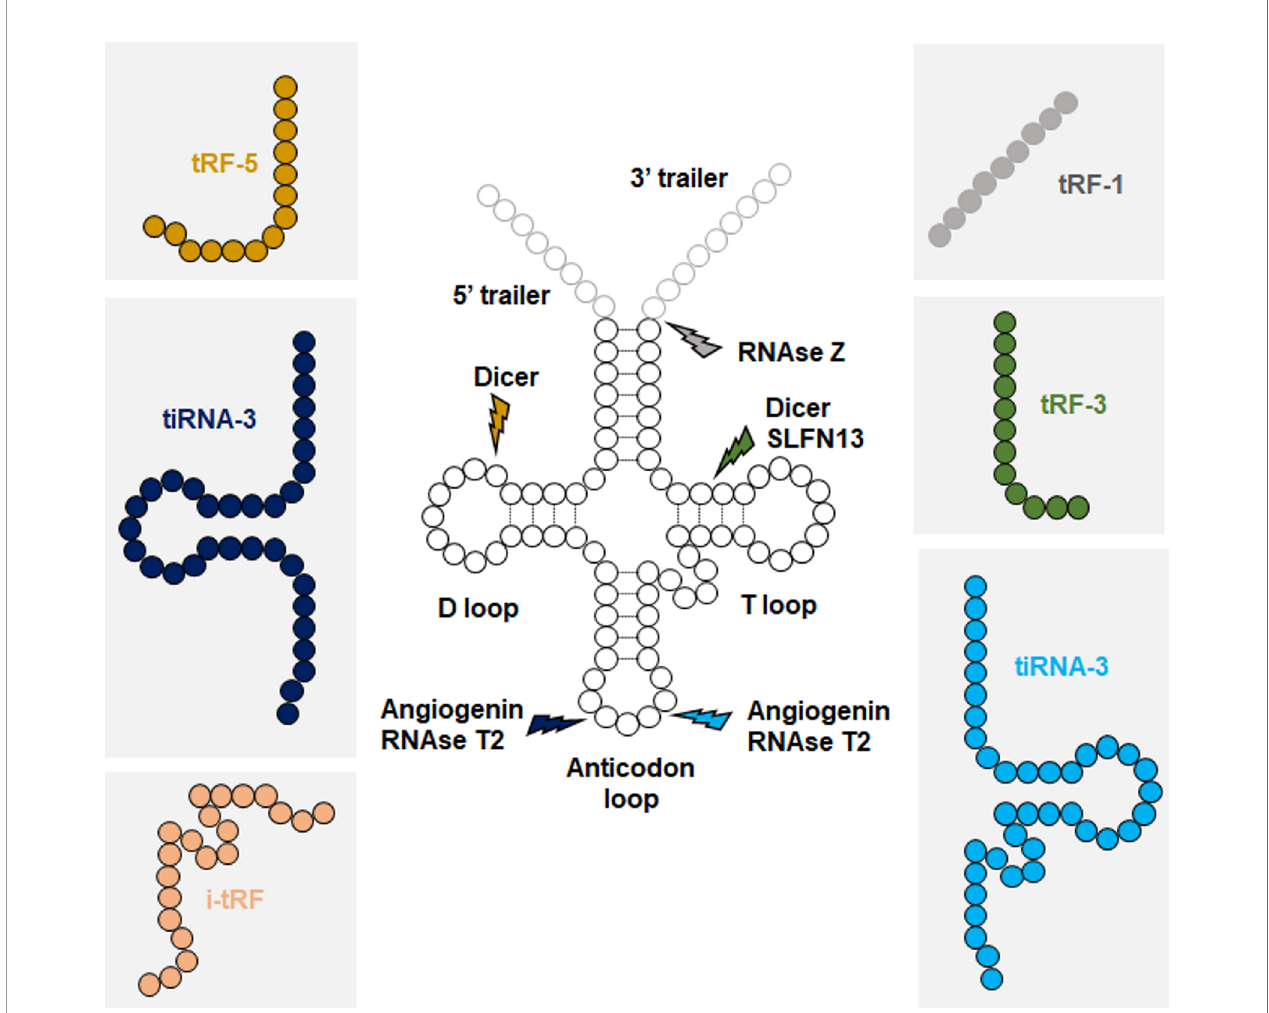
FIGURE 1 | Biogenesis of tRFs. Each class of tRFs are categorized based on where they map on tRNA sequence. tRF-1s are generated from trailer sequences present on primary tRNA transcripts (pre-tRNAs), while other classes are generated from mature tRNAs. Approximate cleavage positions and the responsible endonucleases for each class of tRFs are